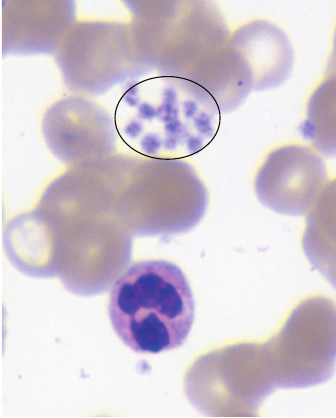
Figure 2: Abundant platelet clusters in peripheral smear.